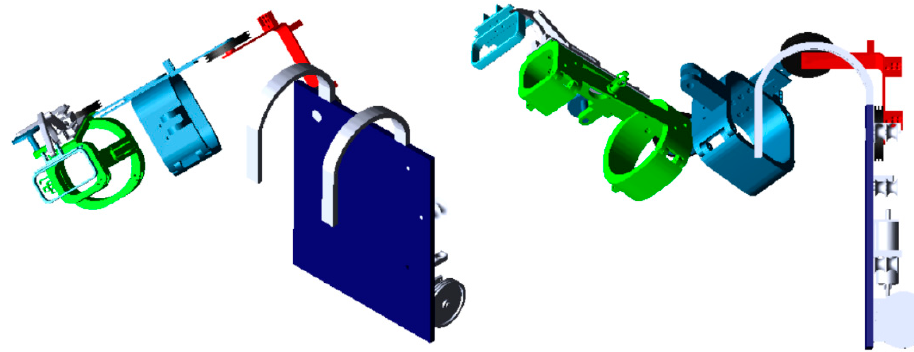
Figure 12. CAD view showing the upper limb rehabilitation exoskeleton.